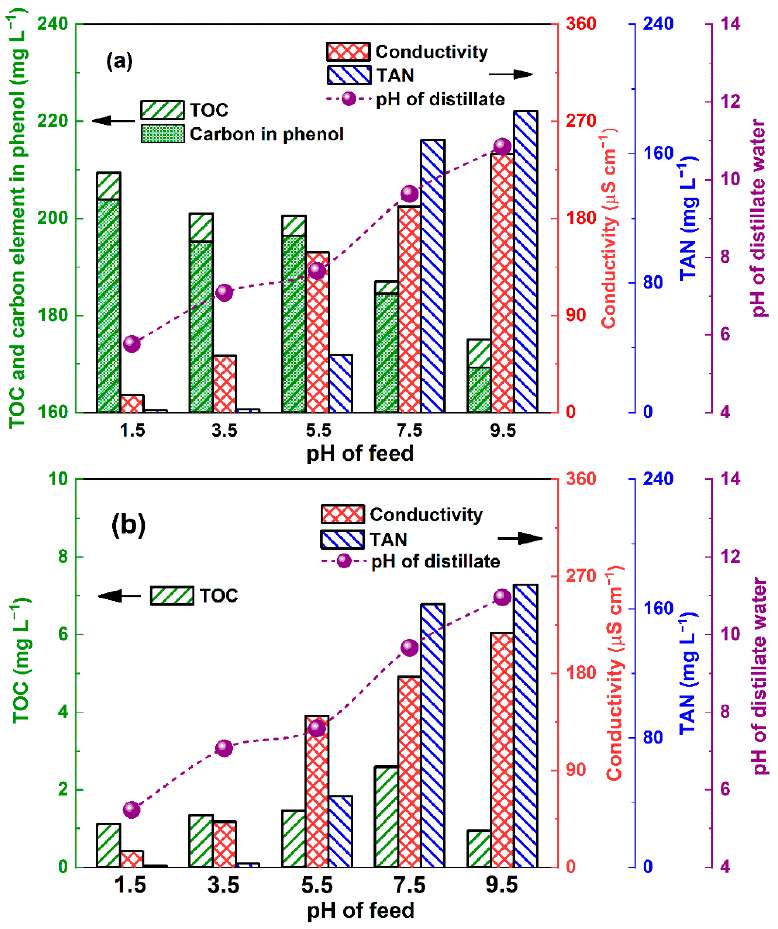
Figure 4. Change in TOC and TAN concentrations as well as conductivity and pH in distillate water with initial pH of feed with phenol ( a ) and without phenol ( b ) (feed average temperature: 61 °C, permeate side pressure: 11.3 kPa).